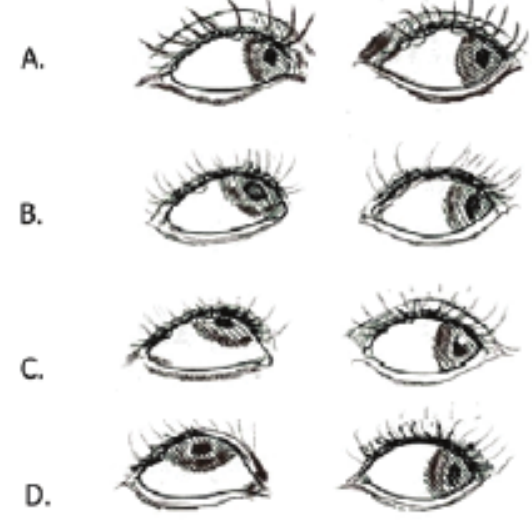
Figure 1. Schematic picture for classification of inferior oblique overaction (IOOA): (A) Grade +1: minimal upshoot of the adducting eye. (B) Grade +2: obvious upshoot of the adducting eye when the abducting eye looks straight across at the lateral canthus. (C) Grade +3: severe upshoot of the adducting eye is seen with the abducting eye in straight abduction. (D) Grade 4: very severe upshoot is considered as grade +4 of